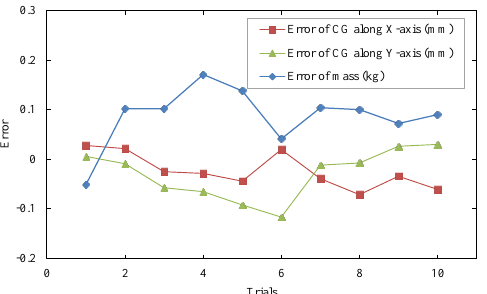
Figure 20. Standard sample mass centroid measurement error.